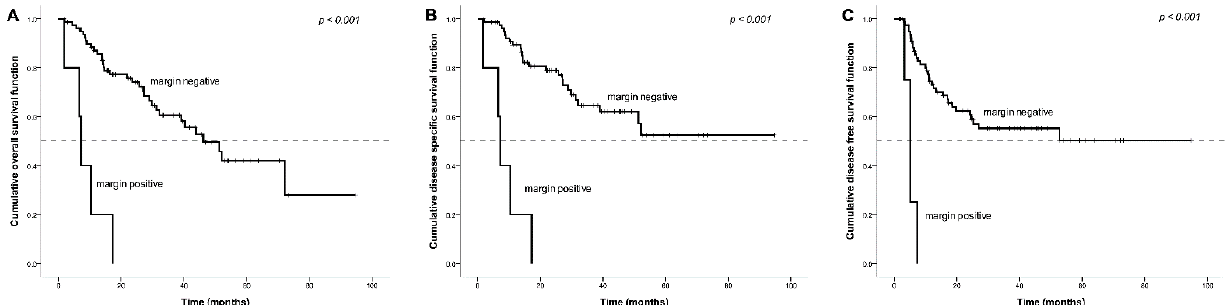
Figure 1. Kaplan–Meier survival curve by the presence of LVI. Impact of lymphovascular invasion (LVI) after salvage total laryngectomy TL on ( A ) overall survival, ( B ) disease-specific survival, and ( C ) disease-free survival.